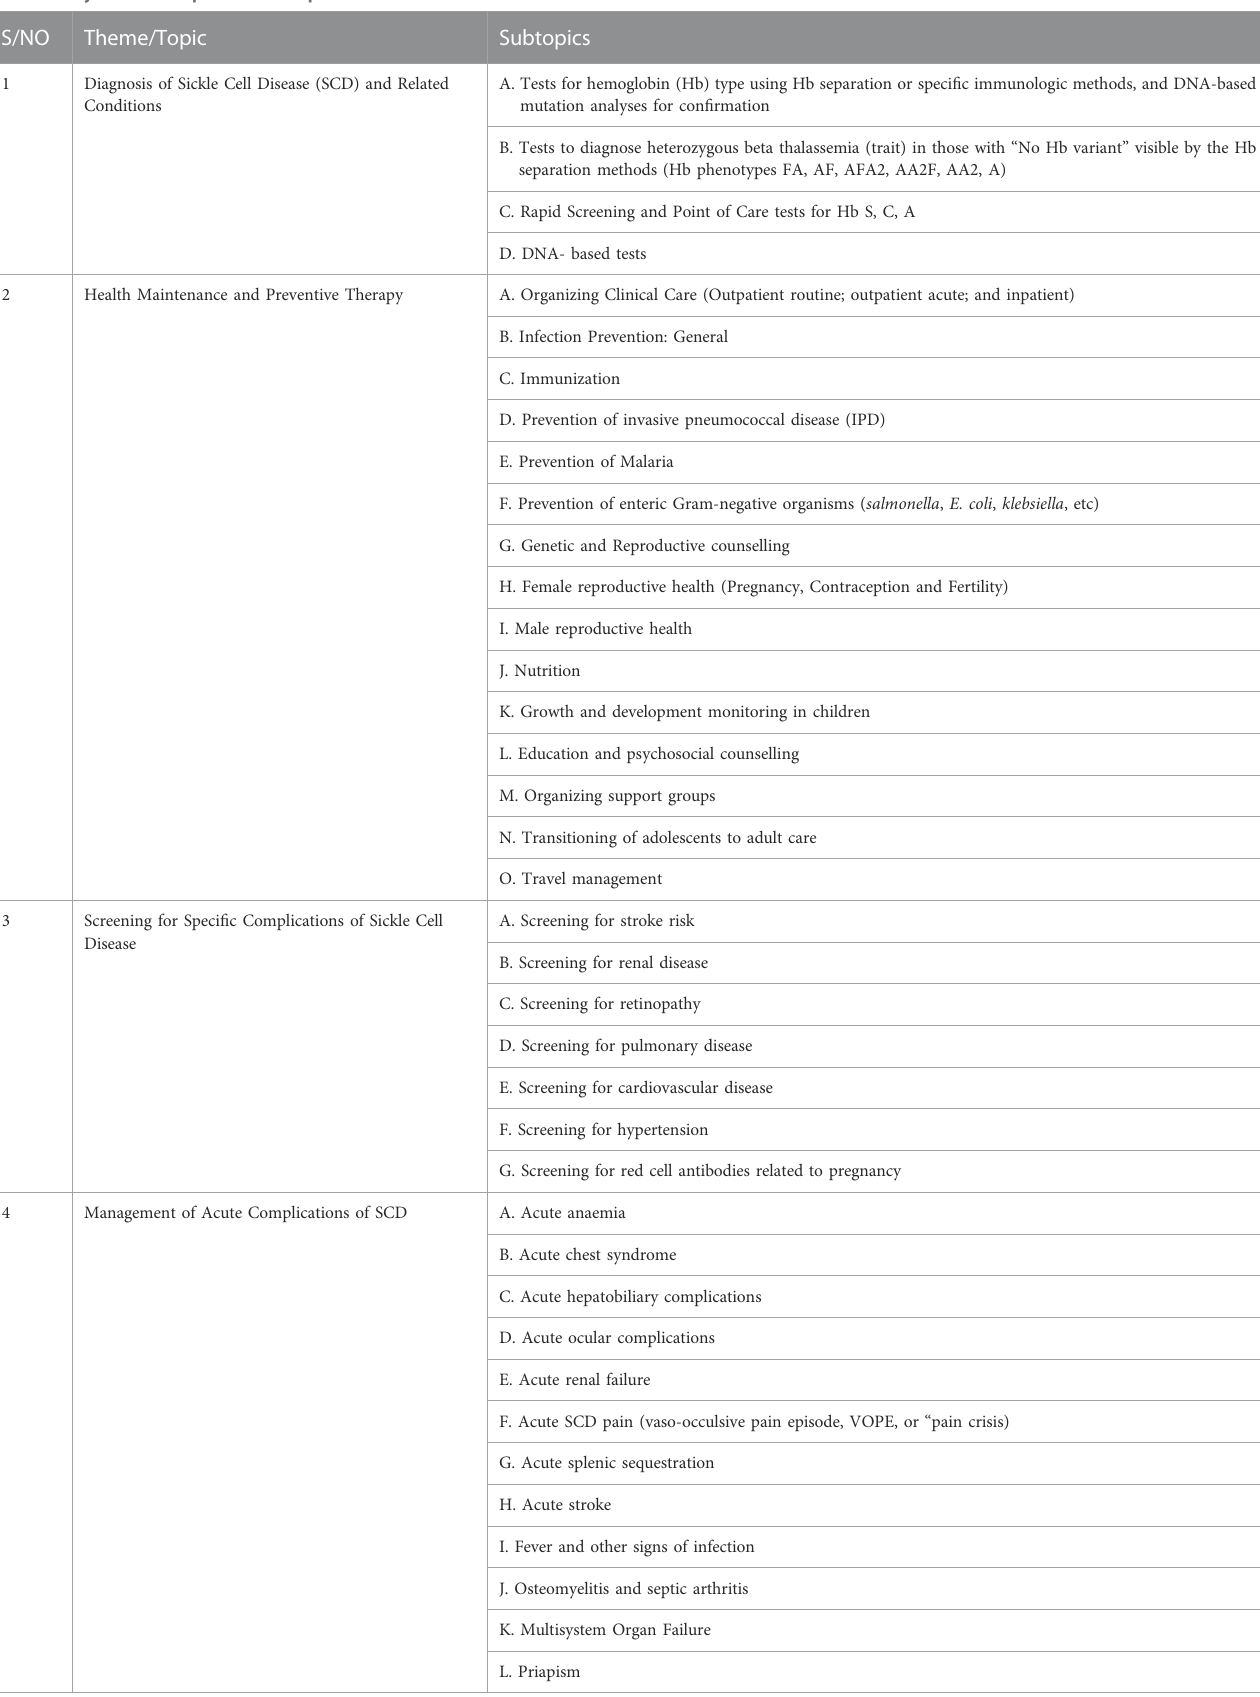
TABLE 4 Major themes/topics and subtopics identi fi